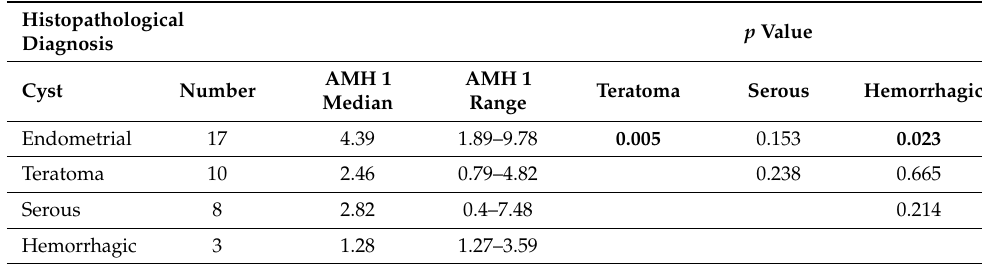
Table 5. Differences in AMH levels before surgery in individual histopathological